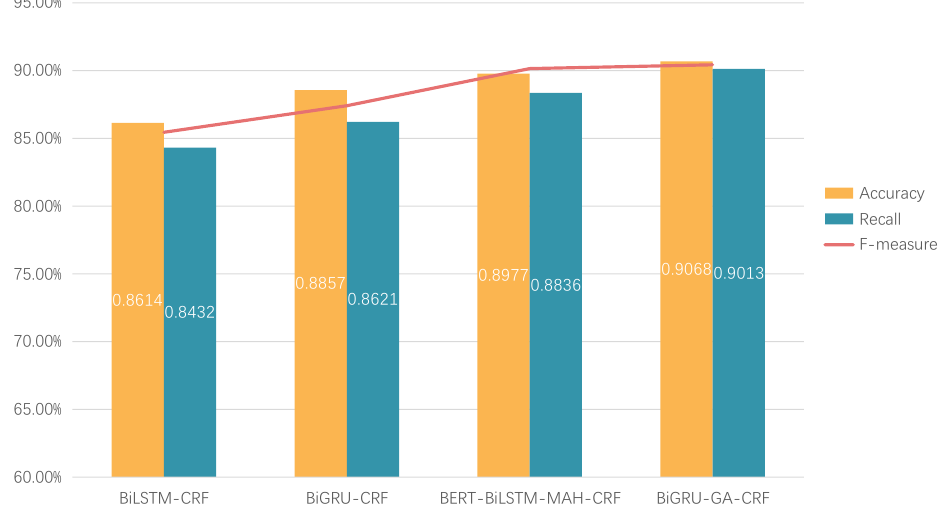
Figure 15. Ablation experiment, GA layer.